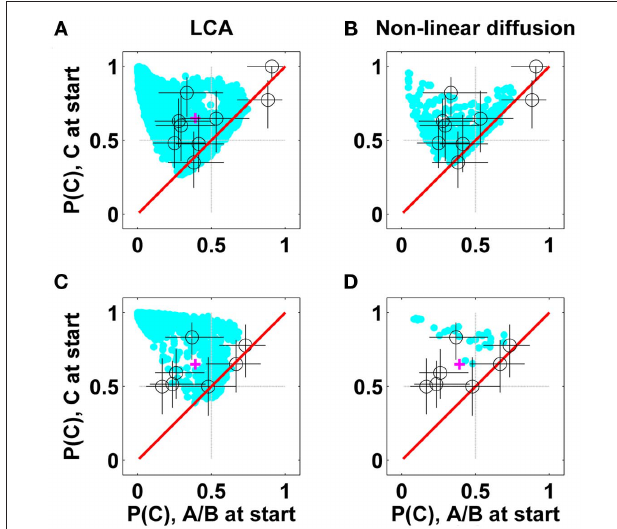
Figure 11 | Predictions for LCA (left panels) and non-linear diffusion with a reflecting lower bound (right panels). The predictions presented in the top panels satisfy the constrain Accuracy (Cons.-Hard) – Accuracy (Incons.-Easy) < 0.24, and in the bottom panels Accuracy (Cons.-Hard) – Accuracy (Incons.-Easy) >